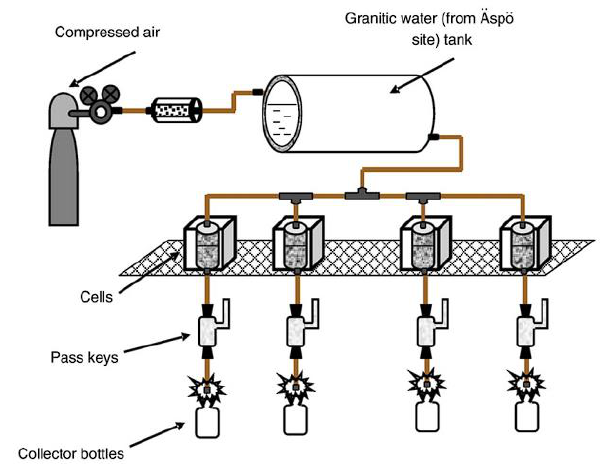
Figure 18. Experimental setup [65].